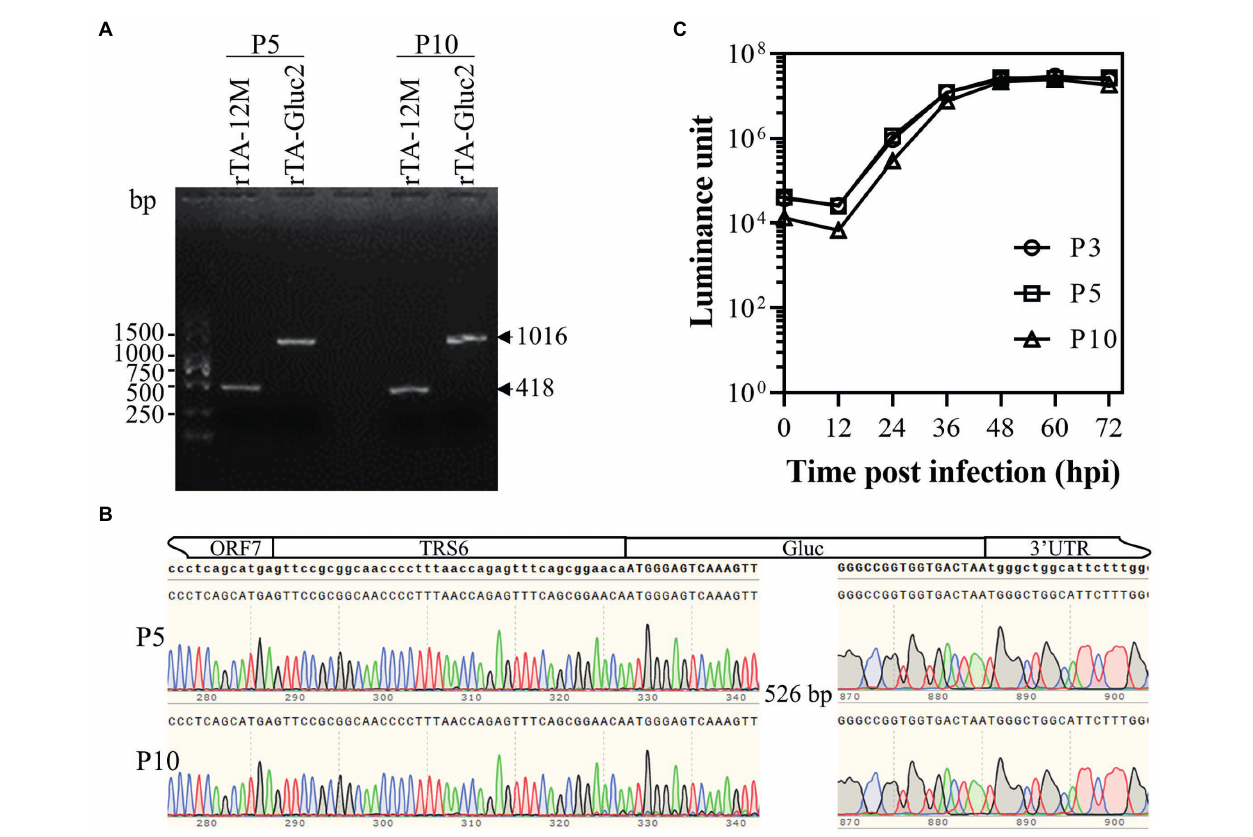
FIGURE 3 | The genetic stability of the Gluc-expressing reporter virus. The Gluc expression cassettes in the recombinant viruses of P5 and P10 were checked by RT-PCR (A) and DNA sequencing (B) , whereas the corresponding regions in the parental viruses were amplified as a control. In addition, the Gluc expression levels by the recombinant viruses of P3, P5, and P10 were evaluated using the multiple-step growth curves (C) . MARC-145 cells were infected with the recombinant viruses at an MOI of 0.01, culture supernatants were harvested at 12, 24, 36, 48, 60, and 72 hpi and titrated by luciferase assay. Each data point represents the mean ± deviation of